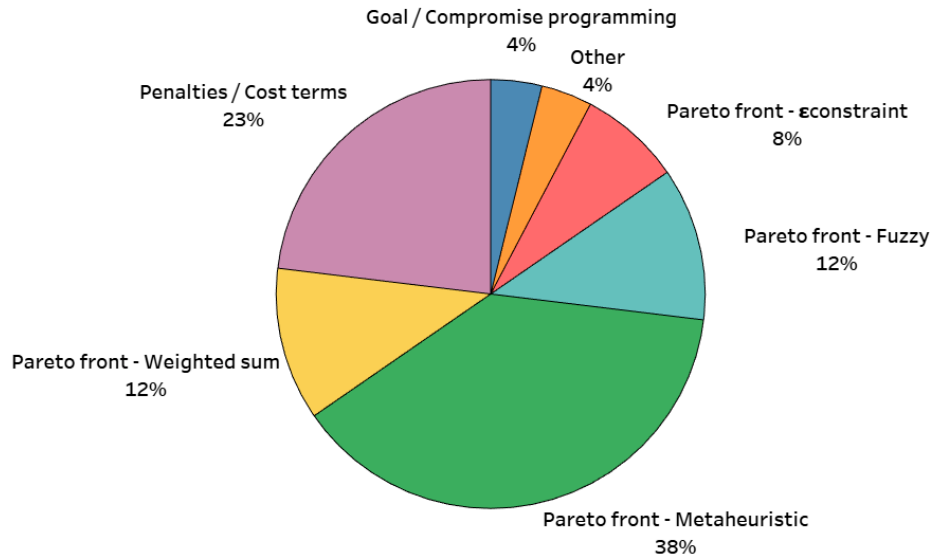
Figure 8. Share of the different multi-objective approaches employed in the literature. Self-elabora- tion.